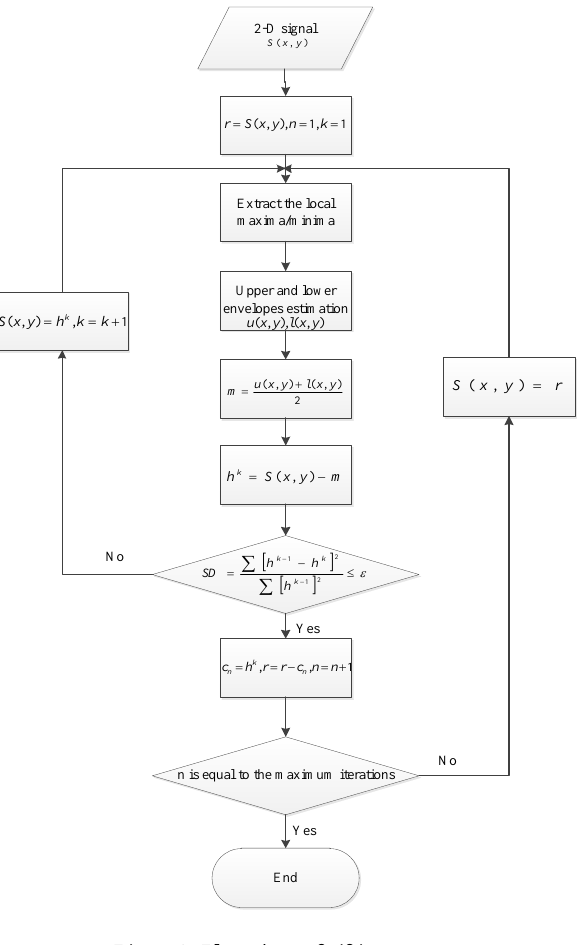
Figure 2. Flow chart of sifting